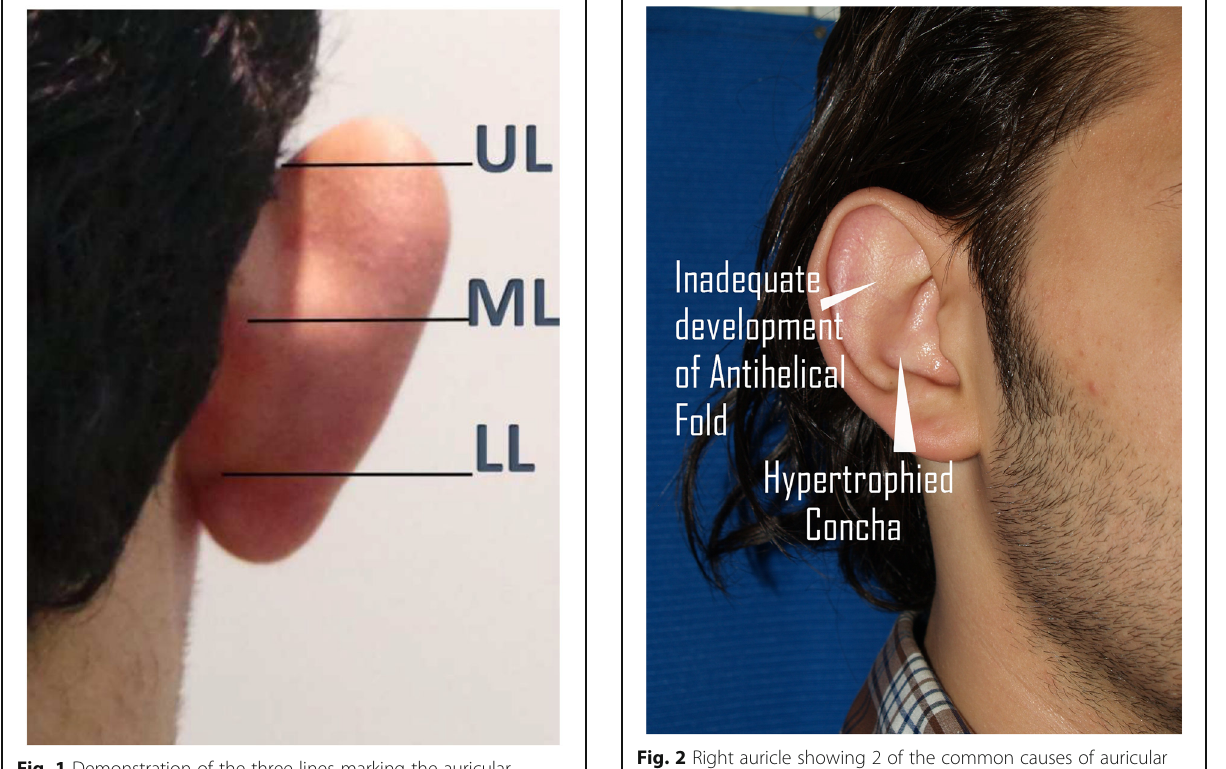
Fig. 1 Demonstration of the three lines marking the auricular protrusion at the UL (upper level), ML (middle level), and LL (lower level)